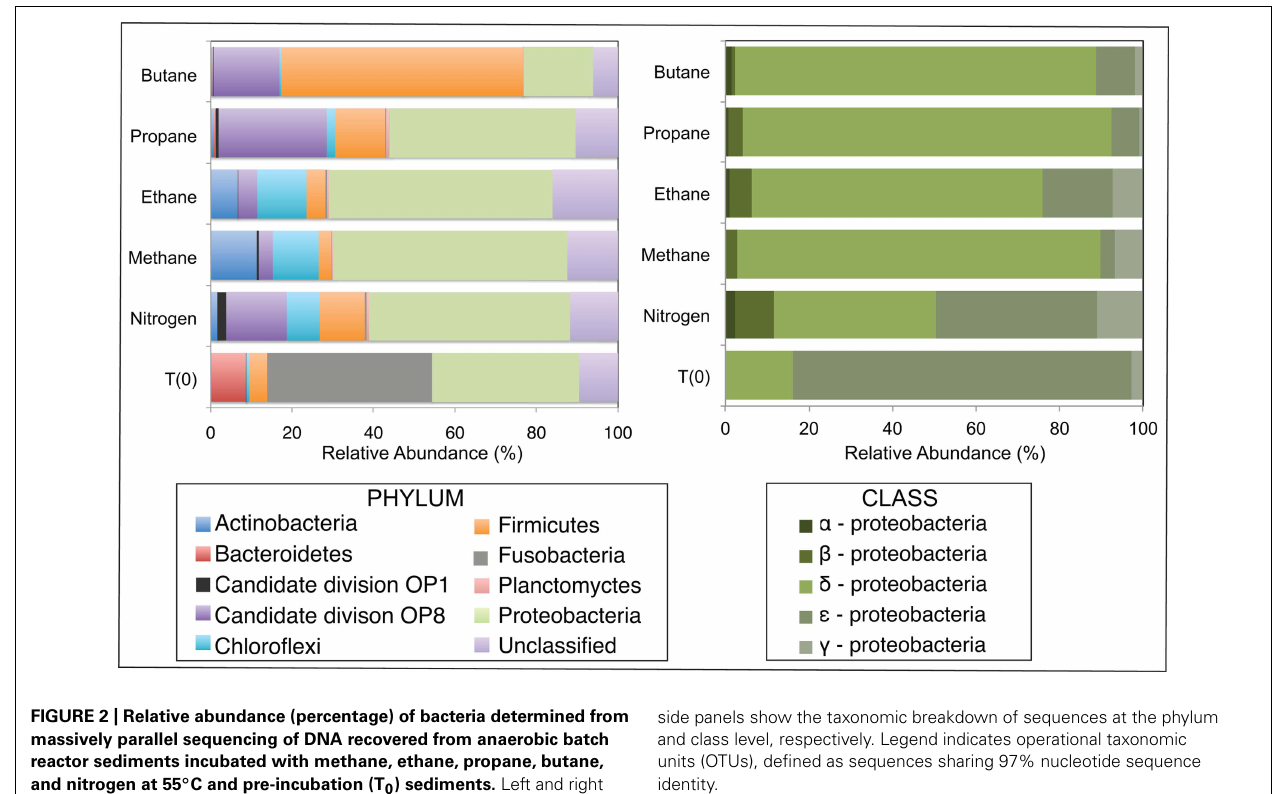
side panels show the taxonomic breakdown of sequences at the phylum and class level, respectively. Legend indicates operational taxonomic units (OTUs), defined as sequences sharing 97% nucleotide sequence identity.